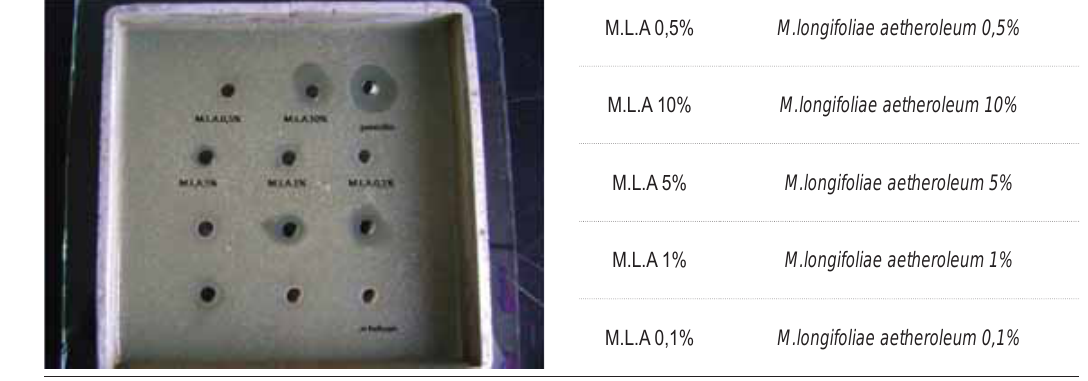
FIGURE 4. Antimicrobial activity against Bacillus subtilis